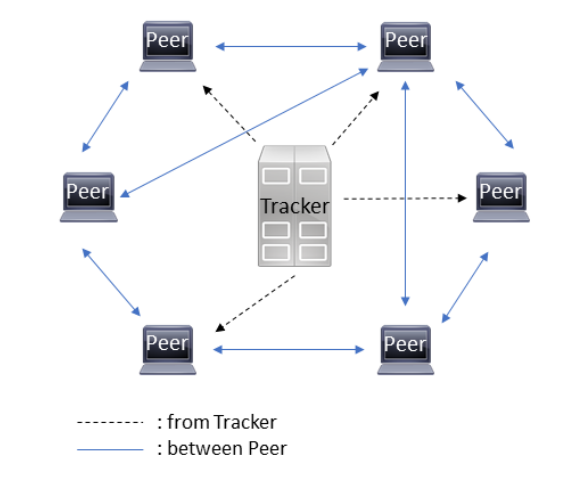
Figure 1. BitTorrent